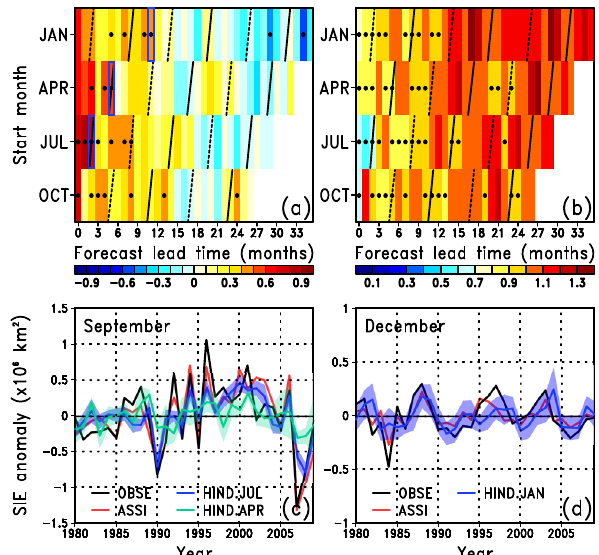
Figure 2. Lead time dependence of (a) SIE AO ACC and (b) SIE AO RMSE ( × 10 6 km 2 ) for January, April, July, and October start hind- casts. The SIE AO ACC scores of hindcasts, which are higher than those of the persistence forecast and statistically significant at the 95% confidence level based on a two-sided Student’s t test, are denoted by black dots. The SIE AO RMSE scores, which are nor- malised by the standard deviation, are denoted by black dots if the values are less than 1.0. Boxes in (a) indicate the lead time of the time series shown in (c) and (d) . Time series of the detrended SIE AO anomaly for (c) September and (d) December, from the observa- tions (OBSE; black line), assimilation (ASSI; red line), and hind- casts started from 1 July and 1 January (HIND.JUL and HIND.JAN; blue line). HIND.JUL is the September SIE AO at 2 months lead time and HIND.JAL is the December SIE AO at 11 months lead time. Blue shading indicates the ensemble spread. In (c) , the September SIE AO at 5 months lead time, started from 1 April (HIND.APR), is superimposed by an aqua line and